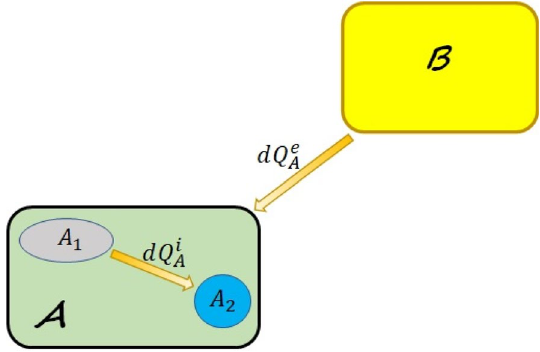
Figure 2. System A interacting with system B . dQ e A is the heat flow, in the exterior of system A due to the interaction with system B , which contributes to d e S A and dQ i A is the heat flow, in the interior of system A , which contributes to d i S A